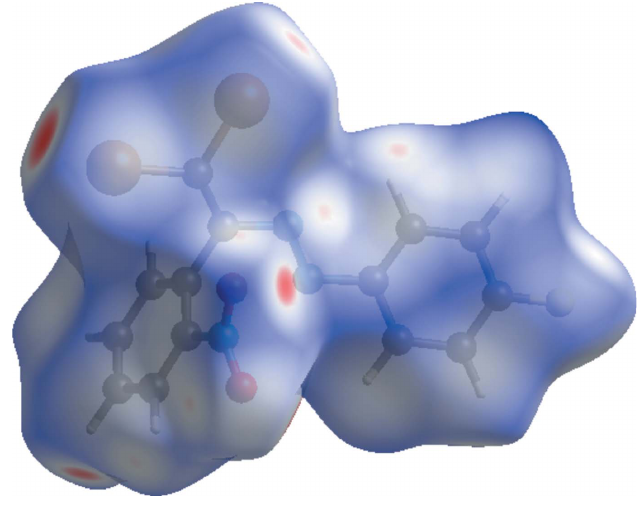
Figure 3 The three-dimensional Hirshfeld surface of the title compound plotted over d norm in the range (cid:4) 0.24 to 1.44